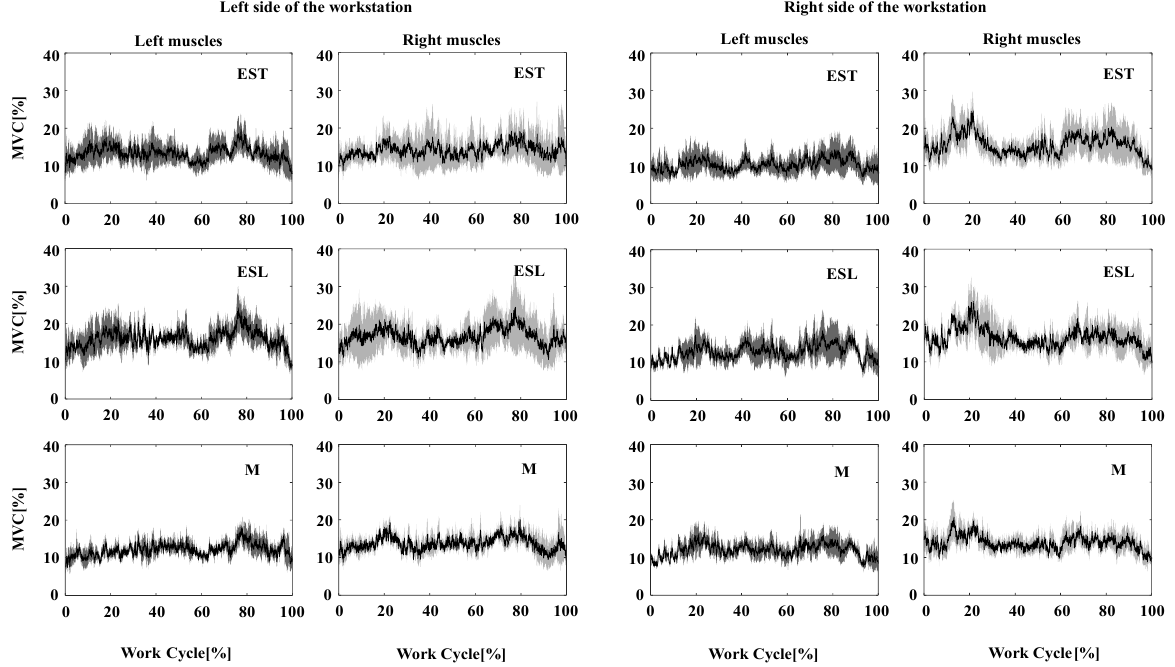
Figure 6. Average values (solid black line) and standard error of the mean (SEM) (light and dark grey coloured areas, left and right sides muscles, respectively) of the muscle activity of paravertebral muscles (Erector Spinae Thoracic (EST), Erector Spinae Lumbar (ESL), and Multifidus (M)) from three workers (W1, W2, and W3) at the left and right workstations, respectively. Table 1 reported the comparisons between the average values ( ± SD—standard devia- tion) of each enrolled worker’s muscle activity (left and right paravertebral complex) while performing activities on the left and right side of the workstation. Table 1. The mean values ( ± SD) of the muscle activity are expressed as a percentage of MVCs. W1 W2 W3 Trunk Muscle Side Trunk Muscle Side Trunk Muscle Side Right side of the workstation Left Right Left Right Left Right EST ESL Left side of the workstation Left Right Left Right Left Right EST 9.5 ± 1.6